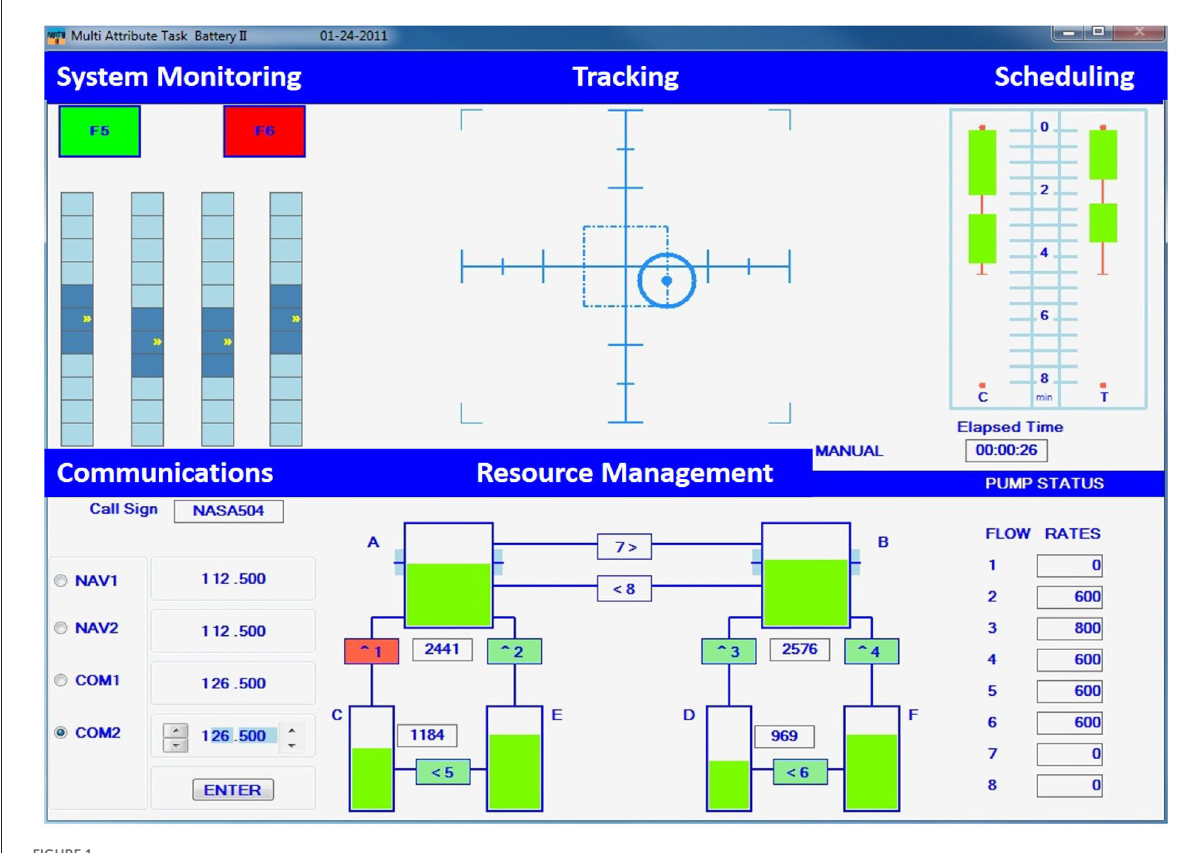
FIGURE1 The NASA MATB-II task environment.